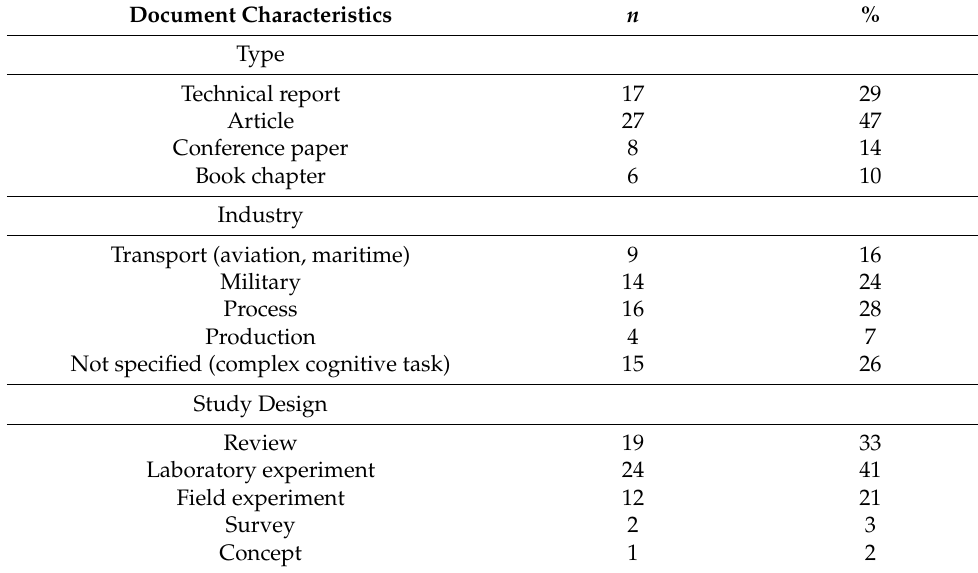
Table 3. Characteristics of documents included in this study ( n =